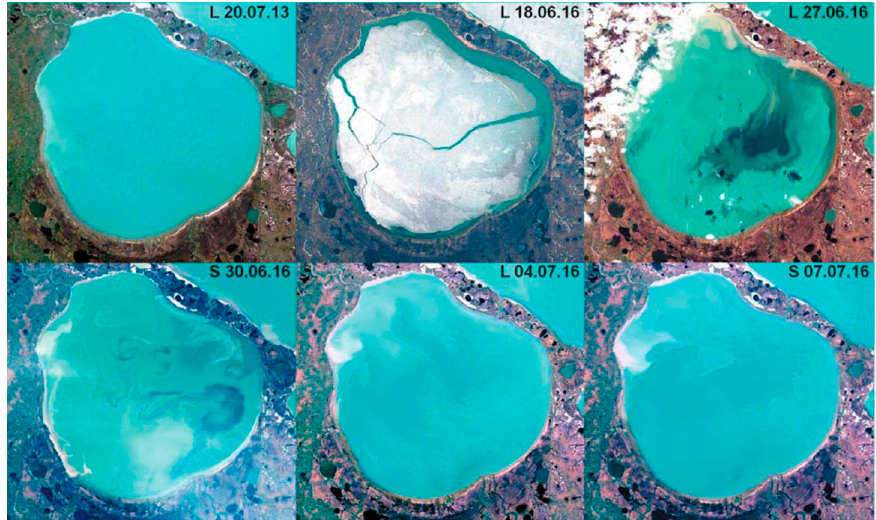
Figure 2. Remote sensing monitoring of Lake Neyto [10]. Satellite images of different dates (number on the map: 1).